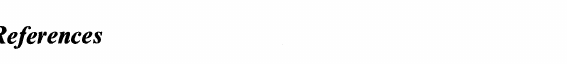
FIGURE 9 Parametrical perturbation 6b in on n.